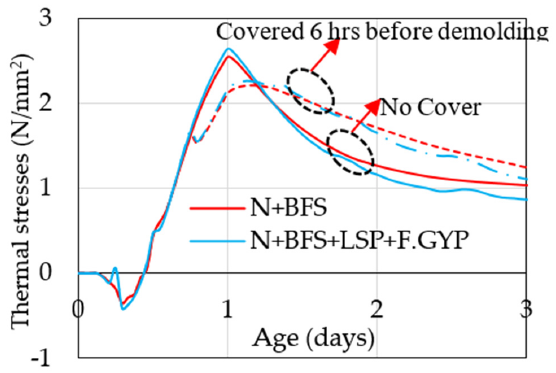
Figure 14. Thermal stresses at the high cracking region.